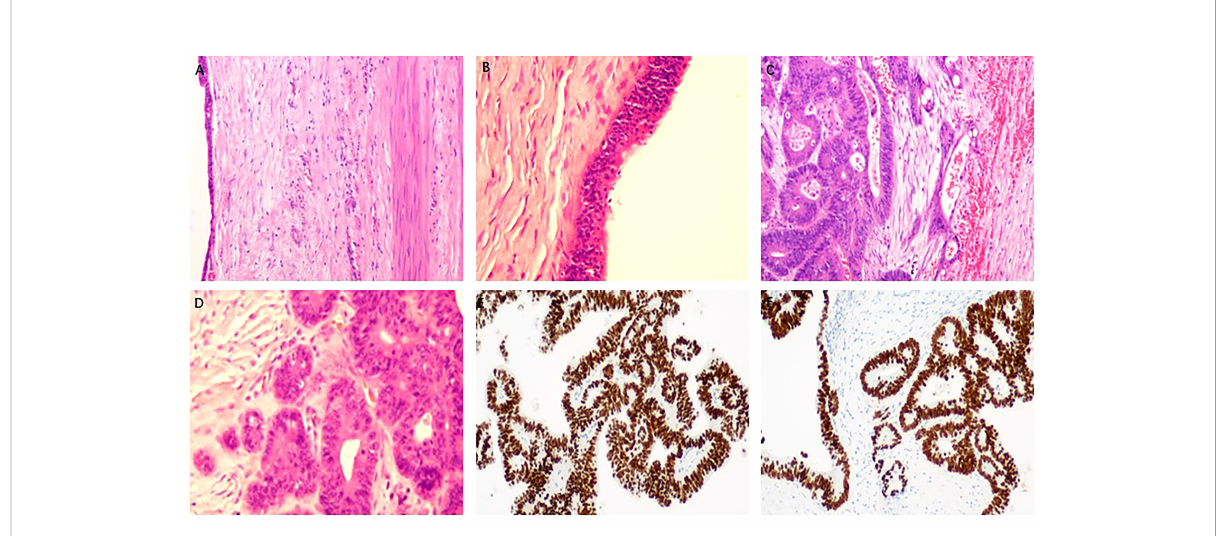
FIGURE 3 Histopathological features of malignant transformation of EC. (A, B) Cuboid columnar epithelium on smooth muscle tissue of cyst wall. (C) Focal cyst wall shows adenocarcinoma with interstitial invasion, and cancer tissue breaks through the basement membrane and invades the interstitium. (D) In the lesion area, glands of different sizes and disorderly arrangement can be seen, and the cancer cells are irregular in shape, different in size, and different in nuclear staining. (E, F) Immunostaining indicated positivity for CDX2 (E) and SATB2 (F) (original magni fi cation: (B, D) ×200; (A, C, E, F) ×100).